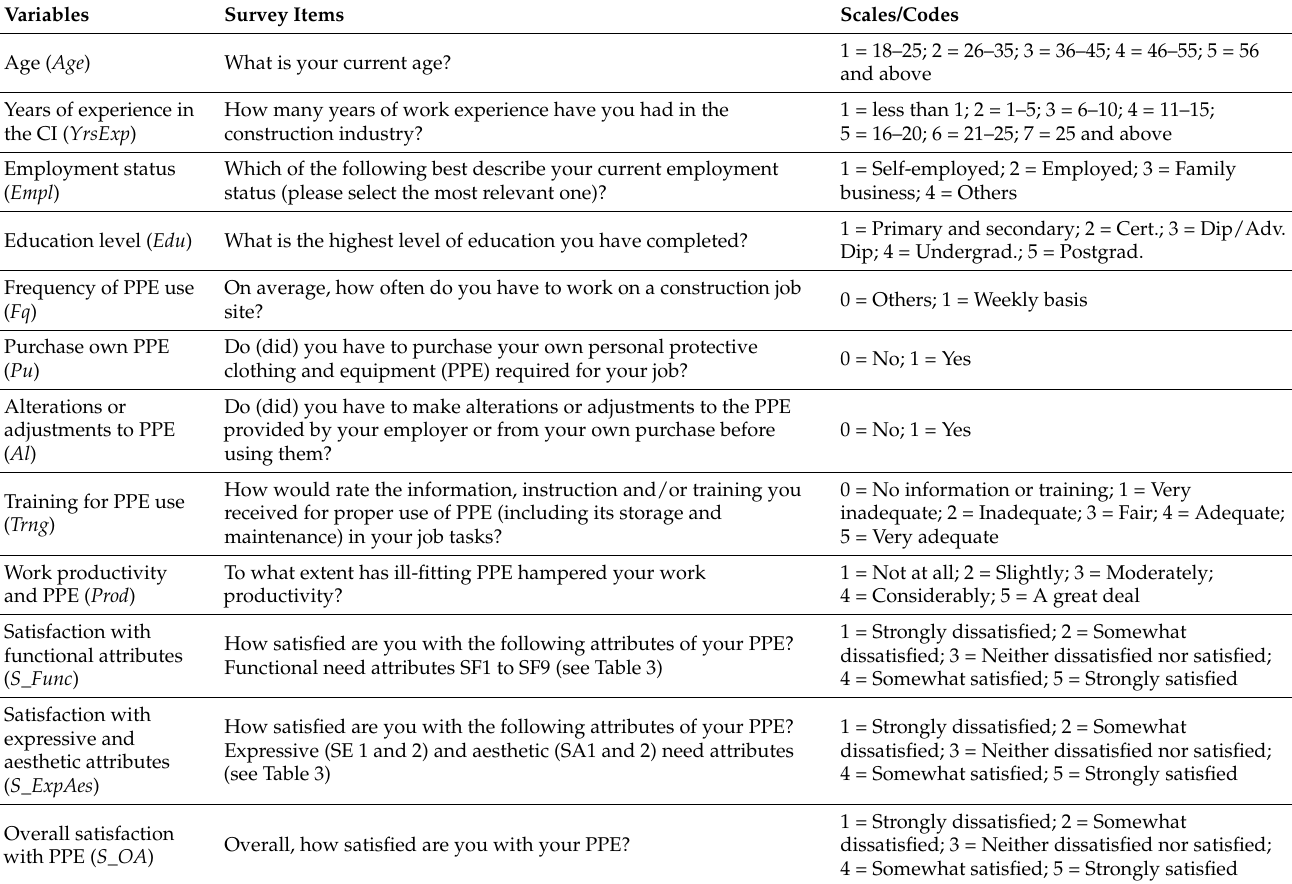
Table 1. The variables in the regression